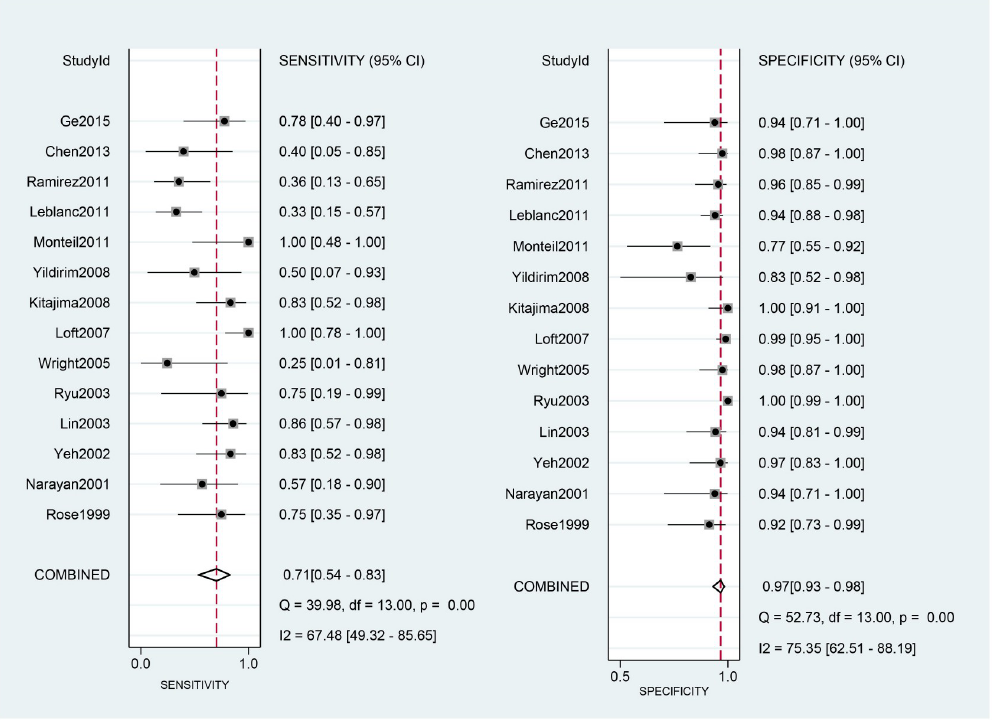
Fig 3. Forest plots for sensitivity and specificity. Abbreviations: CI, confidence interval; df, degrees of freedom.